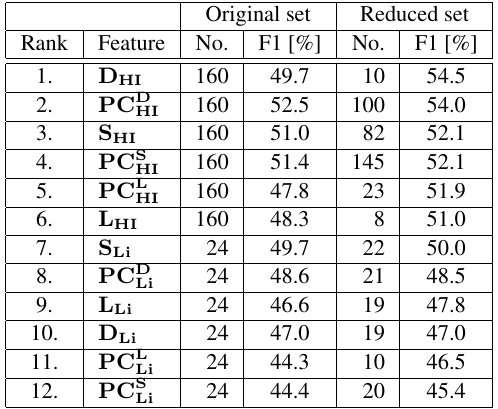
Table 4: Ranking of set of features according to the F1-score (F1) and the number of features (No.) in the original and reduced sets, by applying RF scores of importance